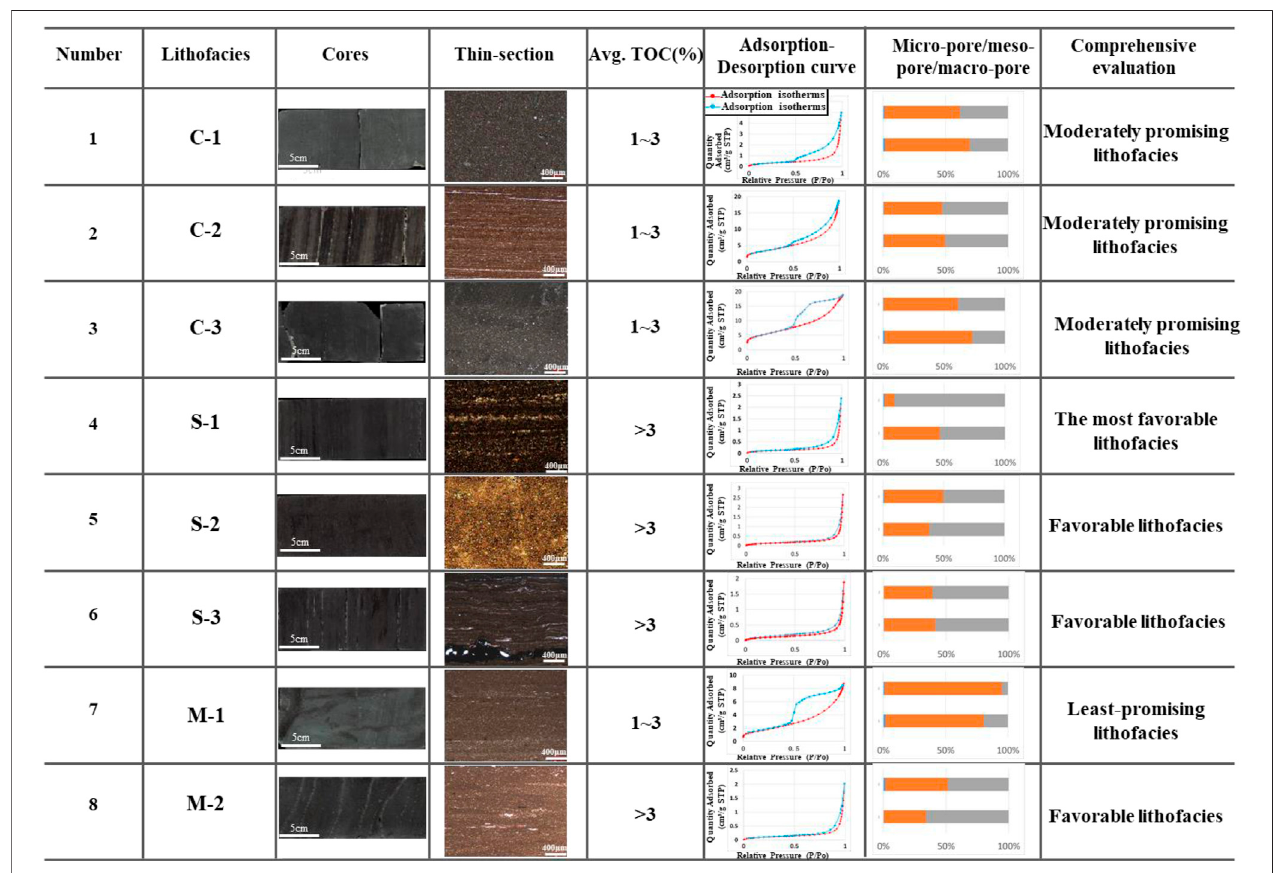
FIGURE 13 | Comparison of experimental results and comprehensive evaluation of different lithofacies types of the Ek 2 shale in Cangdong Sag.